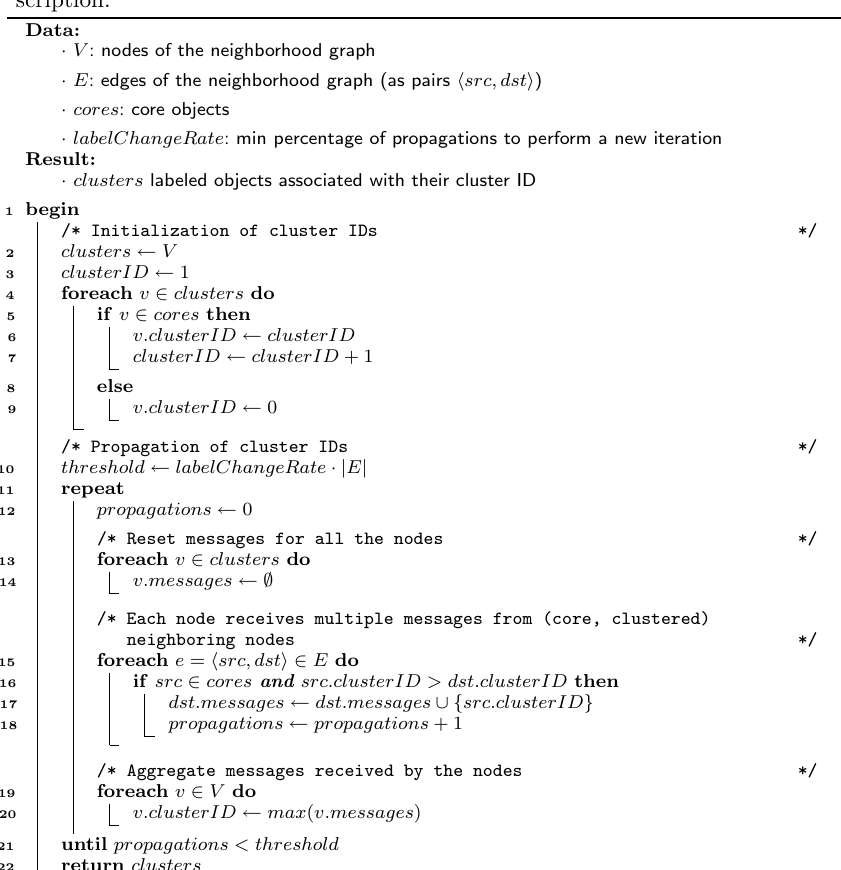
Algorithm 3: findClusters(V,E,cores,labelChangeRate) . Pseudo-code de-